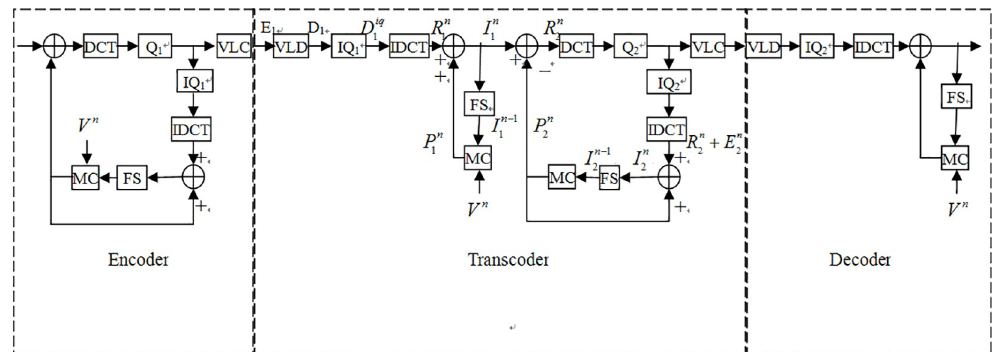
Fig 1. Encoder-transcoder-decoder architecture.